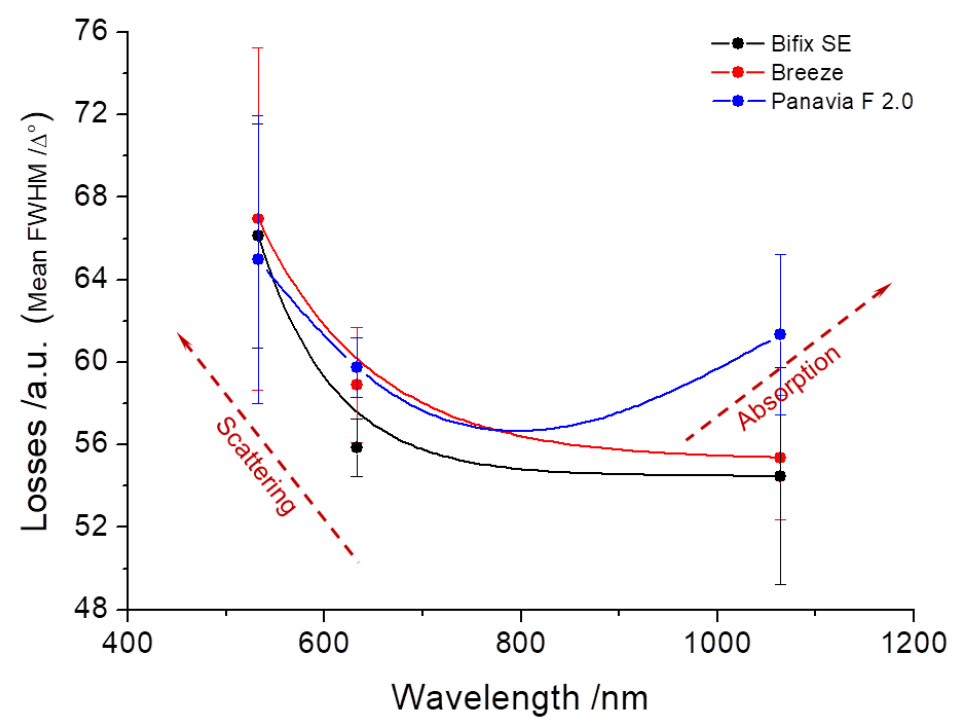
Figure 10. Mean line widths (FWHM) over all layer thicknesses for every wavelength taken from Figure 7. The trends of the loss mechanisms of scattering and absorption can be clearly categorized from Figure 8.